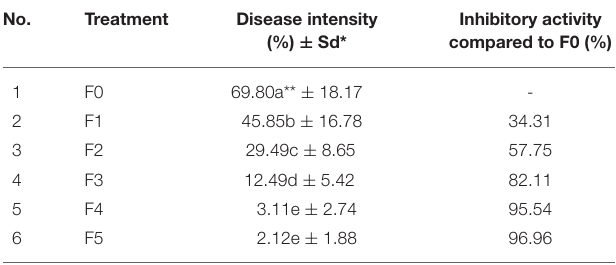
TABLE 5 | Effect of frequency of application of F6 to the disease intensity on chili pepper cultivar Cabe Besar . No.